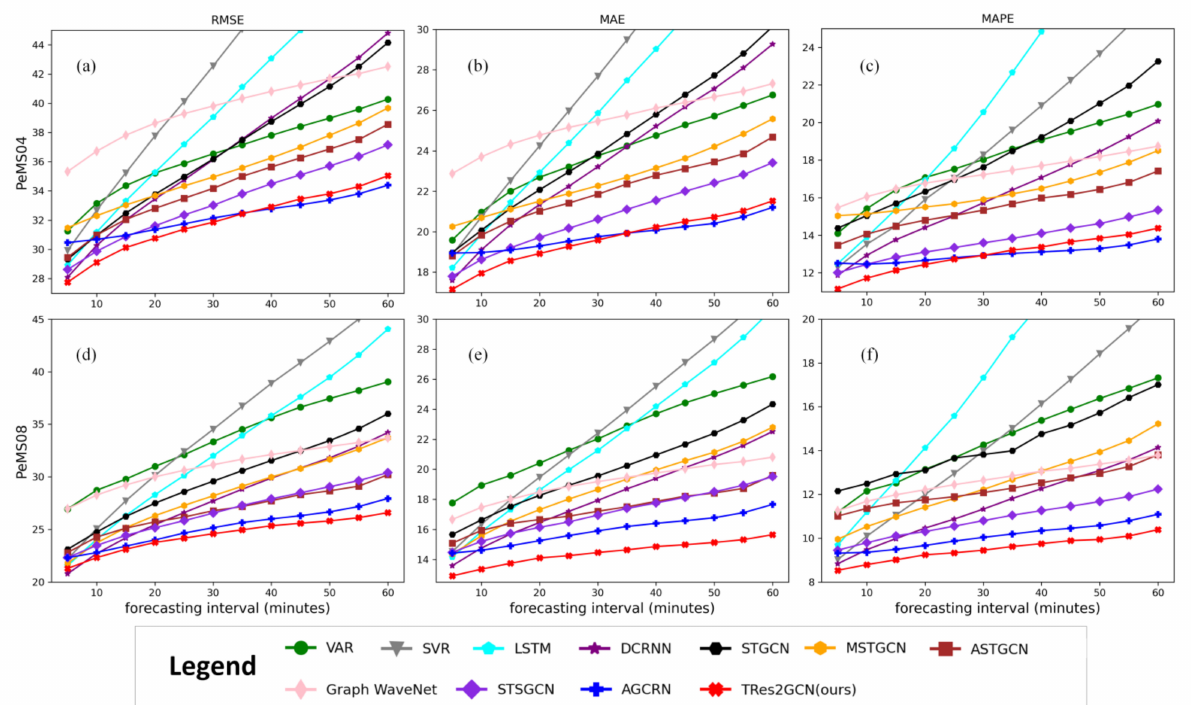
Figure 3. Model comparison under different time spans: ( a ) PeMS04-RMSE, ( b ) PeMS04-MAE, ( c ) PeMS08-MAPE, ( d ) PeMS08-RMSE, ( e ) PeMS04-MAE and ( f )